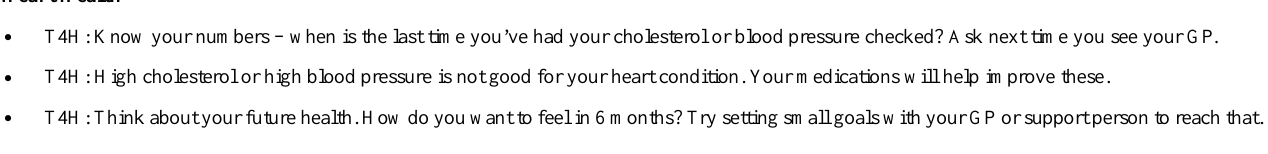
Textbox 1. Examples of SMS text